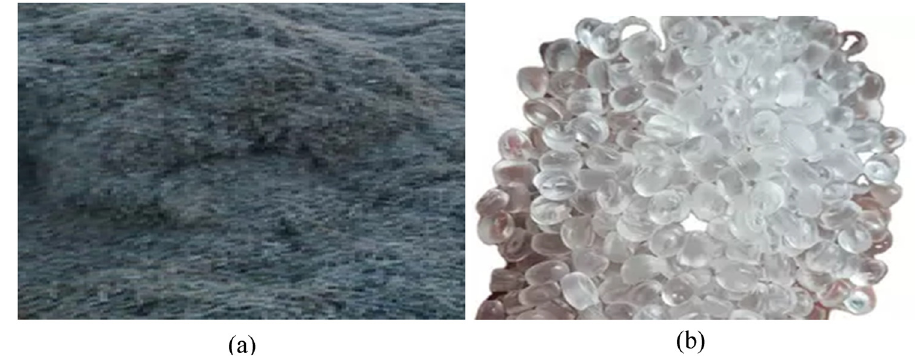
Figure 3: ( a ) Leather bu ffi ng dust employed as a reinforcing particulate; ( b ) recycled EVA granules as a